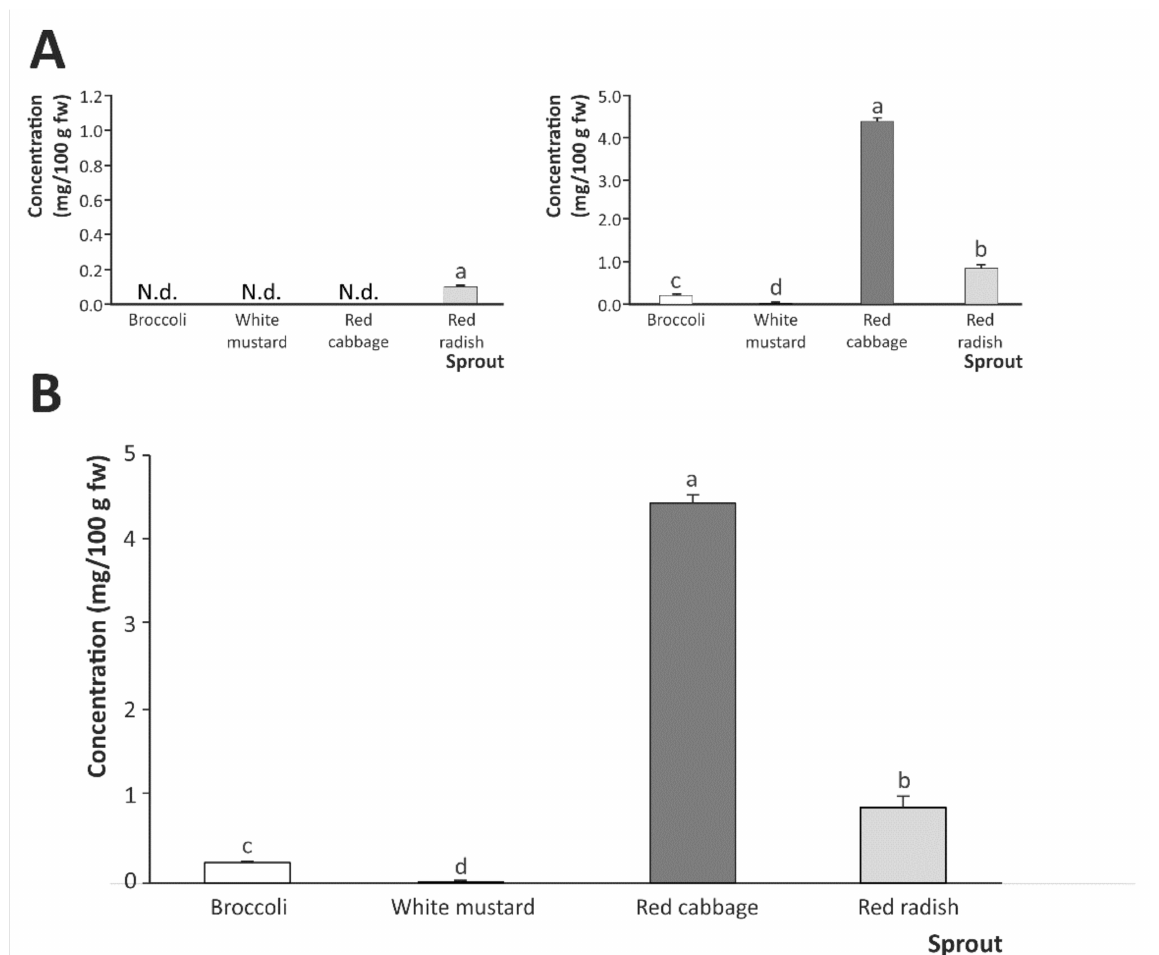
Figure 3. Total content of ITCs and indoles in the digestates after gastric phase ( A , left bar-plot), intestinal phase ( A , right bar-plot), and gastrointestinal phase ( B ). Results are expressed as mean ± SD ( n = 3). Within each plot, bars with different lowercase letters are significantly different at p < 0.01 according to the analysis of variance (ANOVA) and Tukey’s multiple range test. N.d., not